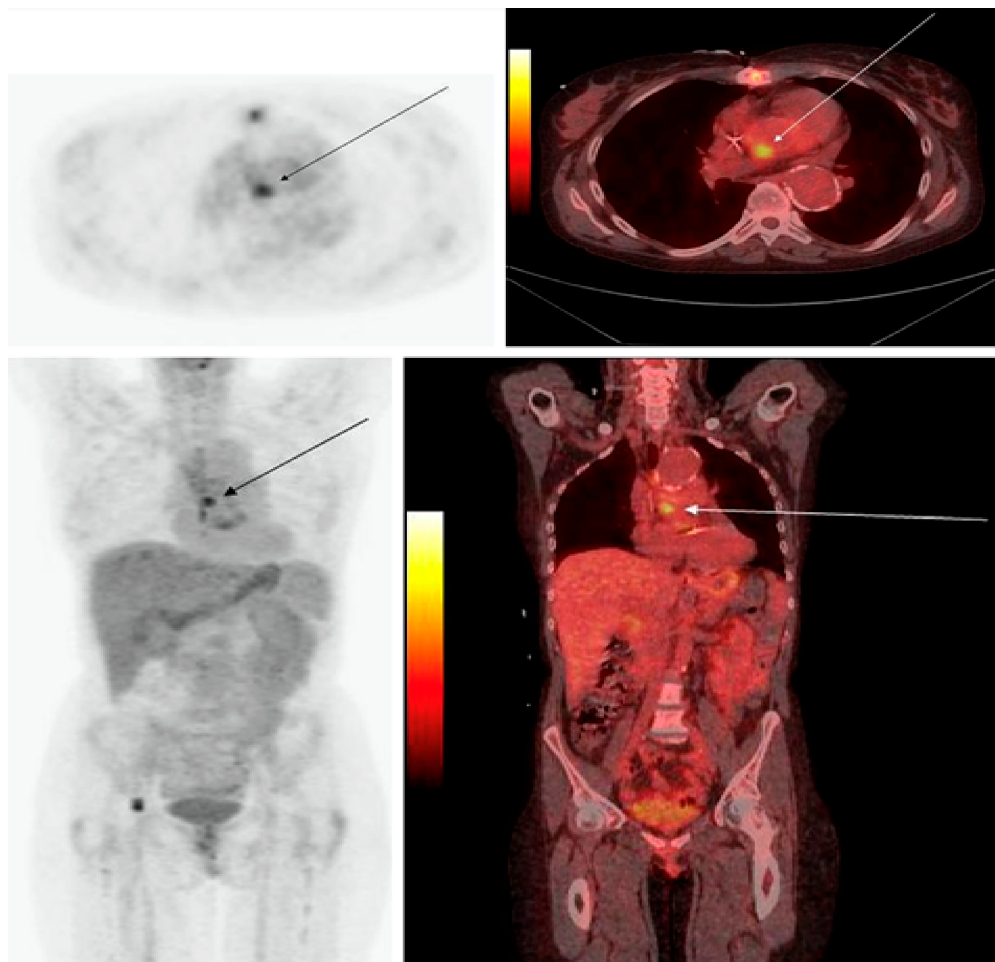
Figure 3. PET/CT in infective endocarditis. The PET/CT image of a 47-year-old female with IE: ( Upper ) transaxial image; ( lower ) coronal image, with PET on the left and the PET/CT fusion image on the right. The images depict a focal region of increased [ 18 F]FDG uptake in the heart at the position of the valvula aorta (with permission from reference [34]).